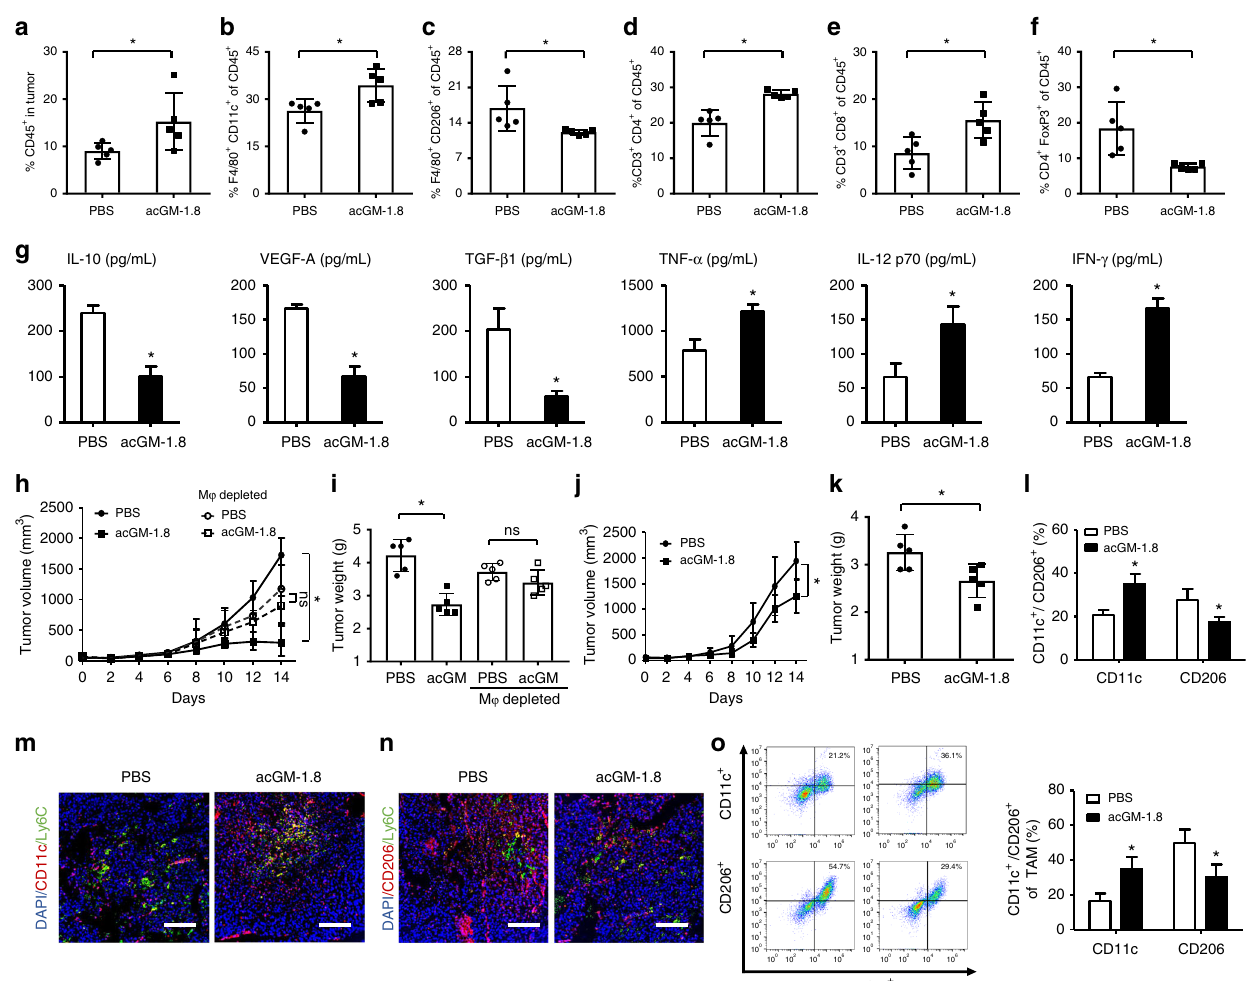
Fig. 6 Macrophages mediate acGM-1.8 ’ s anti-tumor activity. a – f Pro fi ling of immune cell populations in the S180 tumor of in mice. After the 14-day treatment by acGM-1.8 or PBS, the tumor tissue was harvested, processed, and analyzed with fl ow cytometry for the proportion of ( a ) leukocytes (CD45 + ) in tumor cells, ( b ) M1-type macrophages (F4/80 + CD11c + ) in CD45 + cells, ( c ) M2-type macrophages (F4/80 + CD206 + ) in CD45 + cells, ( d ) CD4 + T lymphocytes in CD45 + cells, ( e ) CD8 + T lymphocyte in CD45 + cells, and ( f ) regulatory T cells (CD4 + Foxp3 + ) in CD45 + cells. g Determination of pro- tumor cytokines (IL-10, VEGF-A, and TGF- β 1) and anti-tumor cytokines (TNF- α , IL-12 p70, and IFN- γ ) by ELISA. h , i Evaluation of the anti-tumor effect of acGM-1.8 in S180-bearing mice with macrophages depleted by clodronate liposomes: measurement of ( h ) the tumor size and ( i ) weight after the 14-day treatment; circles and squares denote the PBS and acGM-1.8 treatment, respectively; solid and hollow signs represent mice without and with macrophage depletion, respectively. j – l Evaluation of the anti-tumor effect of acGM-1.8 in S180-bearing nude mice: measurement of ( j ) the tumor size and ( k ) weight after the 14-day treatment; * P < 0.05 versus the PBS treatment; n = 5; and ( l ) the proportion of M1/M2-type macrophages within CD45 + cells in the tumor tissue in the nude mice. m , n Representative images for co-staining of Ly6c + (green) and ( m ) CD11c + (red) or ( n ) CD206 + (red) cells in the tumor tissue of the S180-bearing mice; the cell nuclei were counter-stained with DAPI (blue); scale bar: 100 μ m. o The effect of acGM-1.8 on the phenotype change of tumor-associated macrophages (TAM) ex vivo: macrophages were isolated from the tumor, cultured in vitro, treated with acGM-1.8 for 48 h, and analyzed for ( o ) their M1/M2 phenotype change by the fl ow cytometry; * P < 0.05 vs. the PBS treatment; ns: no signi fi cance; n =